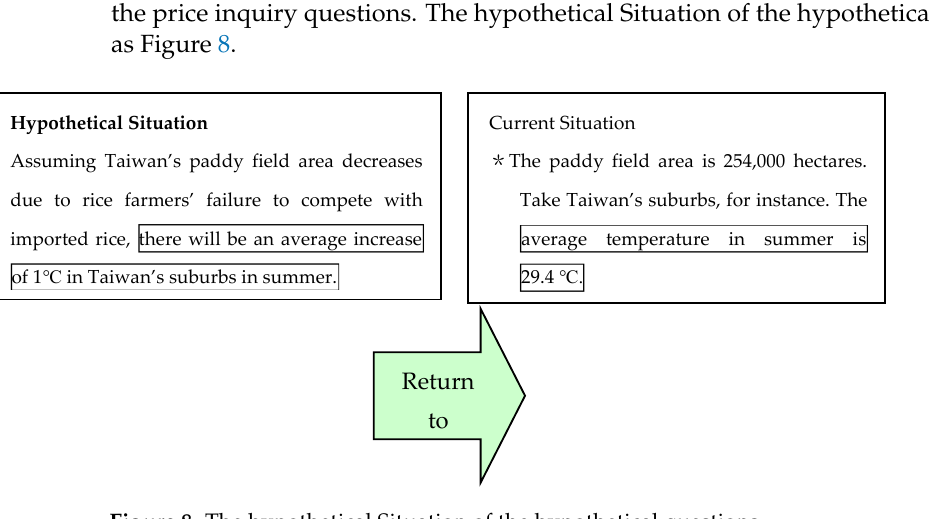
Figure 8. The hypothetical Situation of the hypothetical questions.